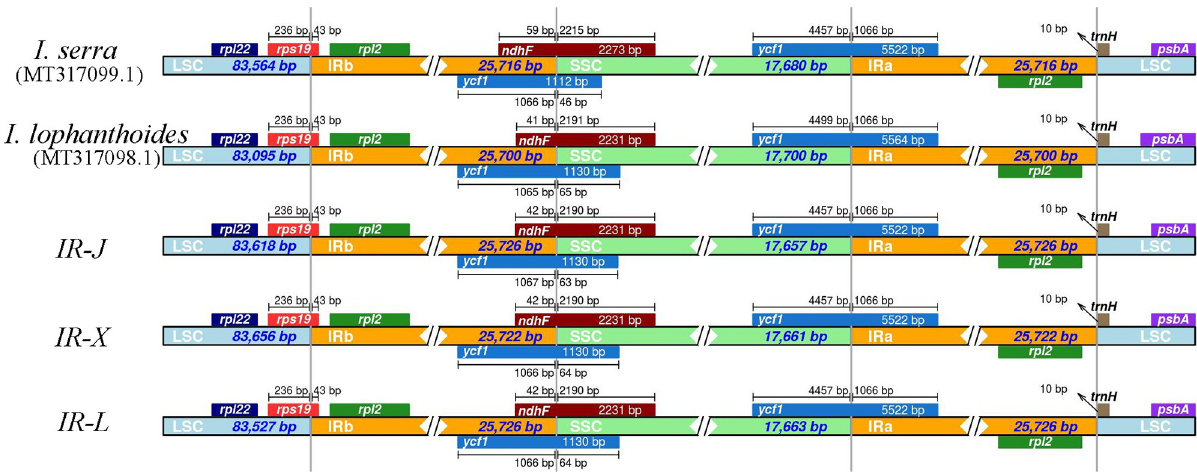
Fig 4. Comparison of the LSC, SSC, and IR border regions among the five Isodon chloroplast genomes of examined in this study. IR-J , IR-X , and IR-L are the three accessions of I . rubescens